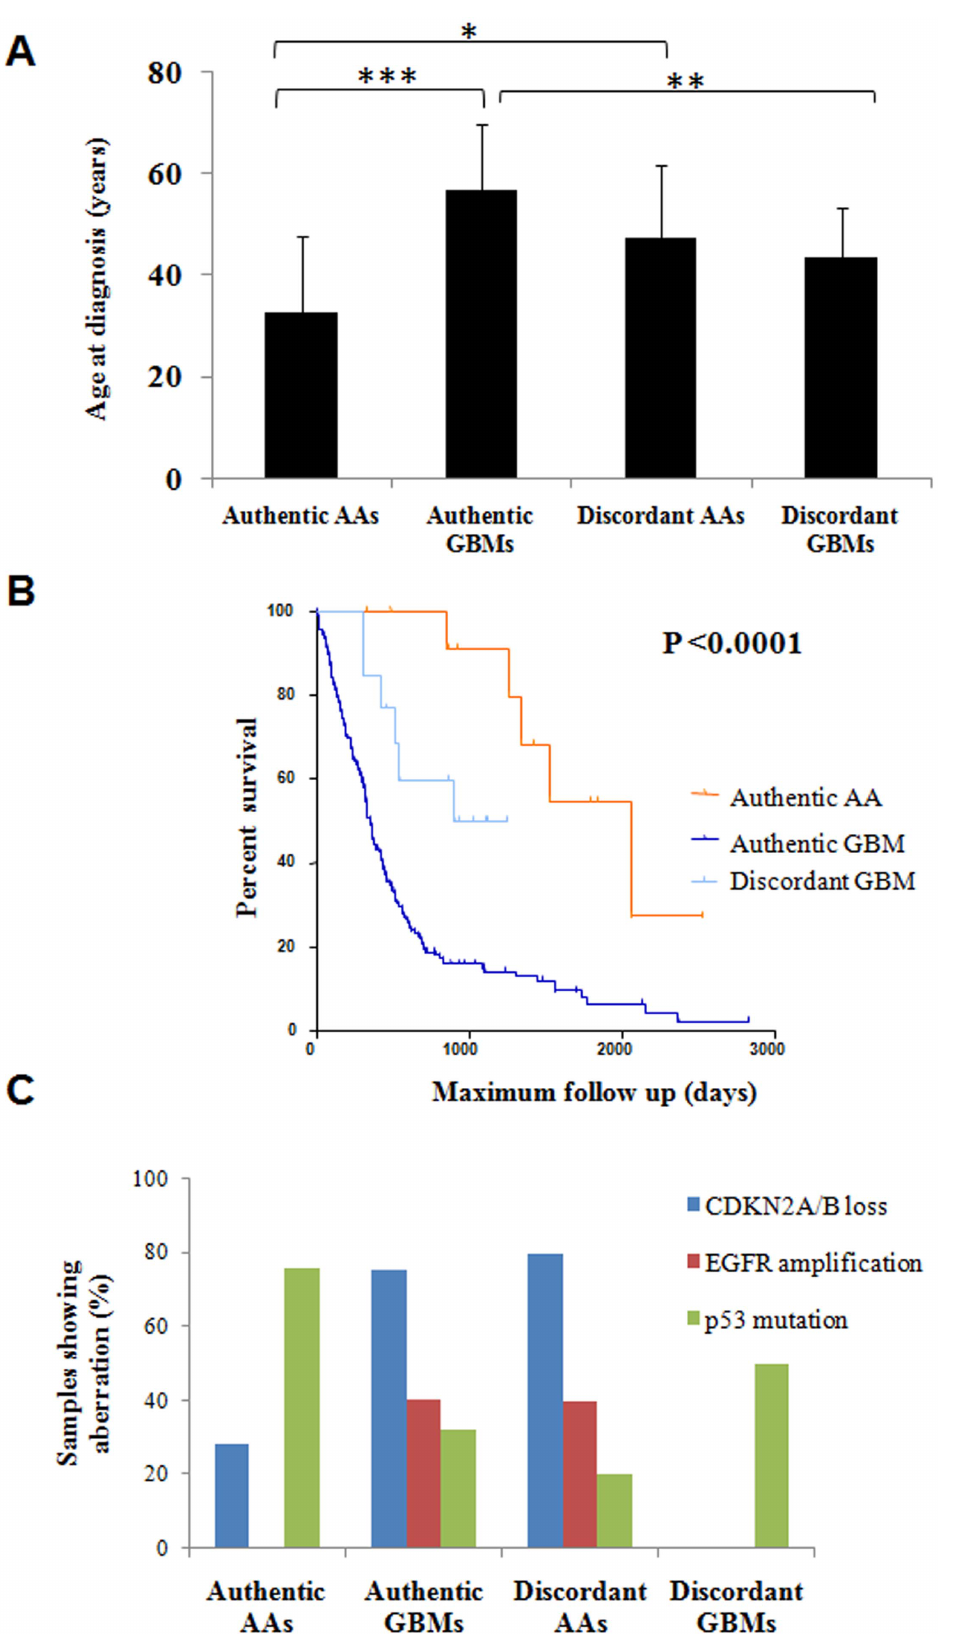
Figure 6. Discordant samples do not exhibit clinical features and molecular markers of its histologic grade. A. The average Age at